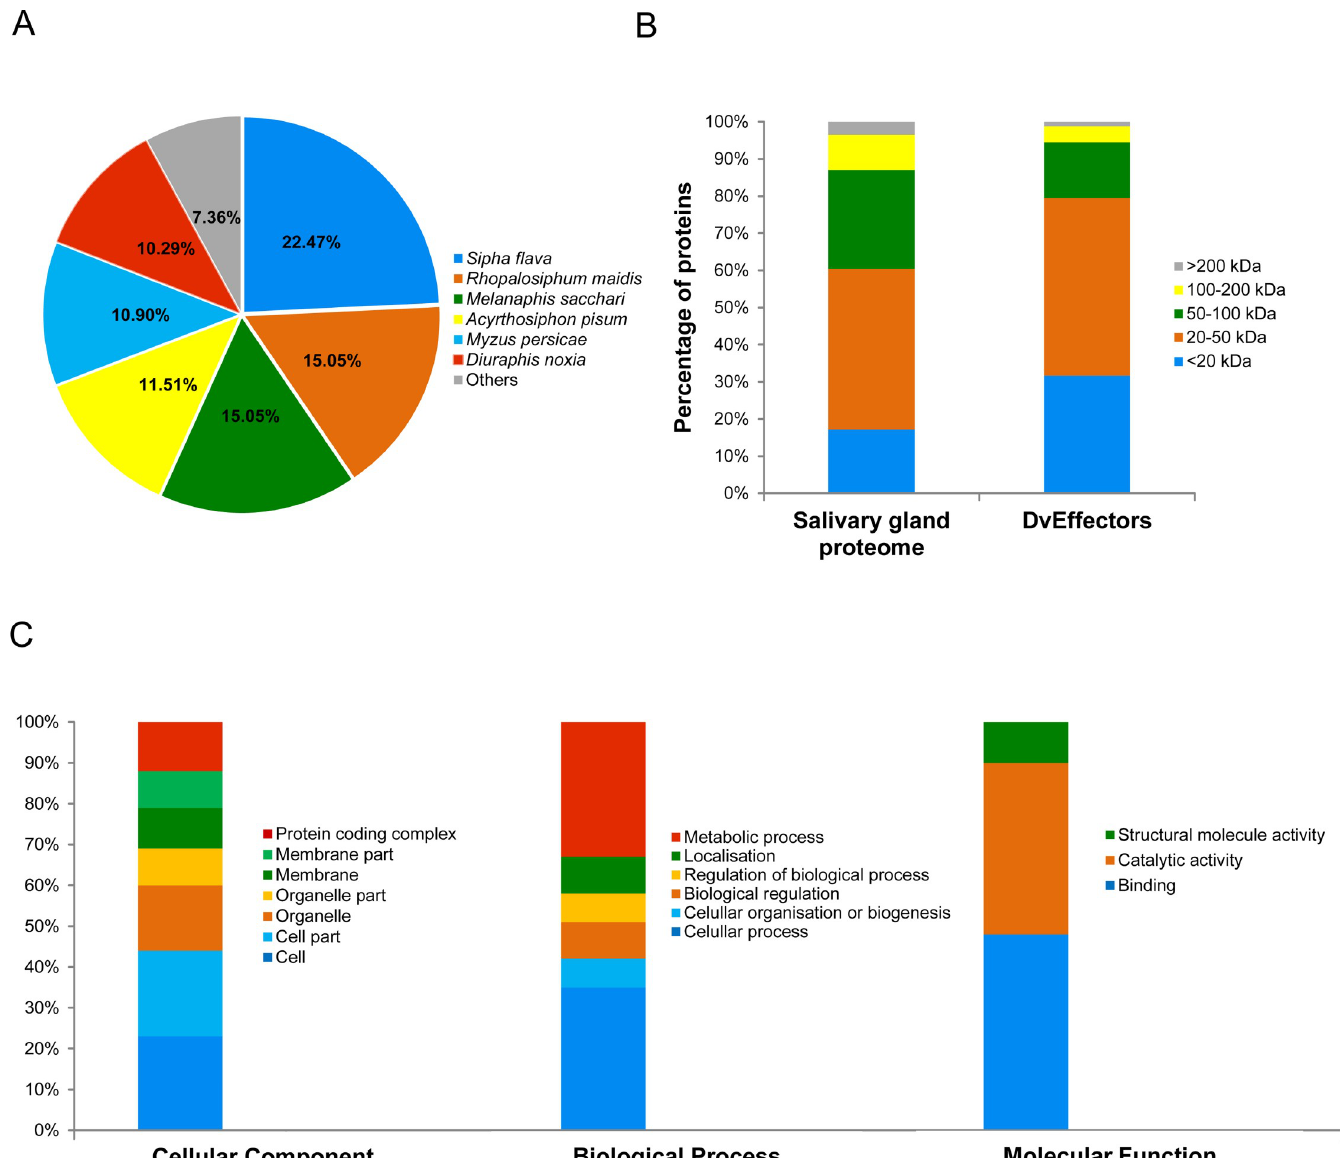
Fig 1. Characterisation of the salivary gland proteome. Gene ontology characterisation of the salivary gland proteome of D . vitifoliae larvae feeding on root galls of Teleki 5C ( V . berlandieri x V . riparia ). A) Protein top blast hit analysis ranked by species; B) Molecular weight distribution [kDa] of 1511 proteins of the salivary gland proteome and the secreted DvEffectors subset (420 proteins); C) GO enrichment analysis conducted with Blast2Go.